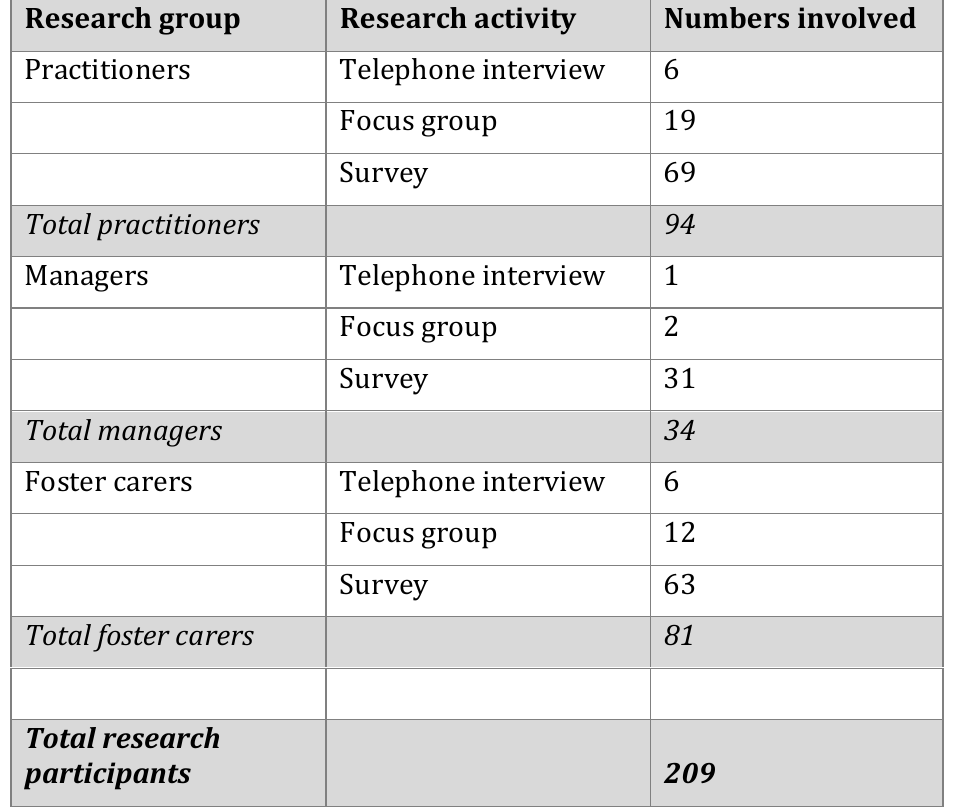
Table 1: Research